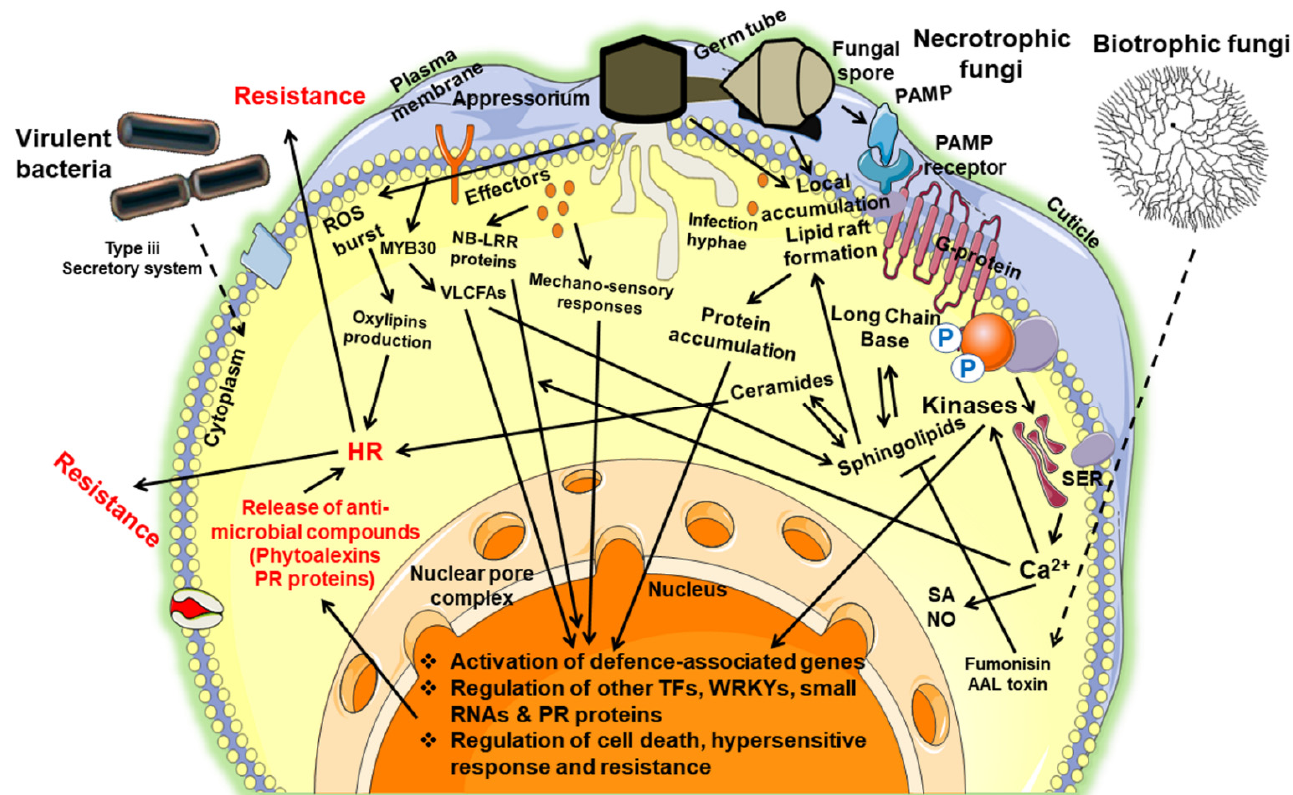
Figure 1. The schematic diagram represents the response of diverse lipids in plant–pathogenic interactions for various phytopathogens (bacteria and fungi). A variety of lipids and their associated proteins play an essential role in regulatory pathways of resistance against devastating pathogens. During pathogen infection, the downstream signaling pathways, including jasmonic acid-dependent and hypersensitive responses and the release of antimicrobial compounds, are modulated by ceramides (fungi), sphingolipids (fungi), VLCFAs (bacteria), MYB30 (bacteria), phospholipases (bacteria and fungi), and Phyto-oxylipins (fungi). At the back end, this mechanism of imparting resistance against phytopathogens is directly or indirectly controlled by ROS bursting, calcium signaling, mechano-sensory responses, lipid raft, and the surface perception of elicitors by interacting with other transcription factors, phospholipases, and kinases. Additionally, during pathogen infection, the “cuticle” (made up of certain cutin monomers or wax components) responds faster to the pathogen elicitors. Thus, it activates plant disease resistance through PTI and ETI. Table 1. Involvement of membranous lipids and their associated enzymes during plant–pathogen interaction. Substrate Enzyme Involved Products Functions